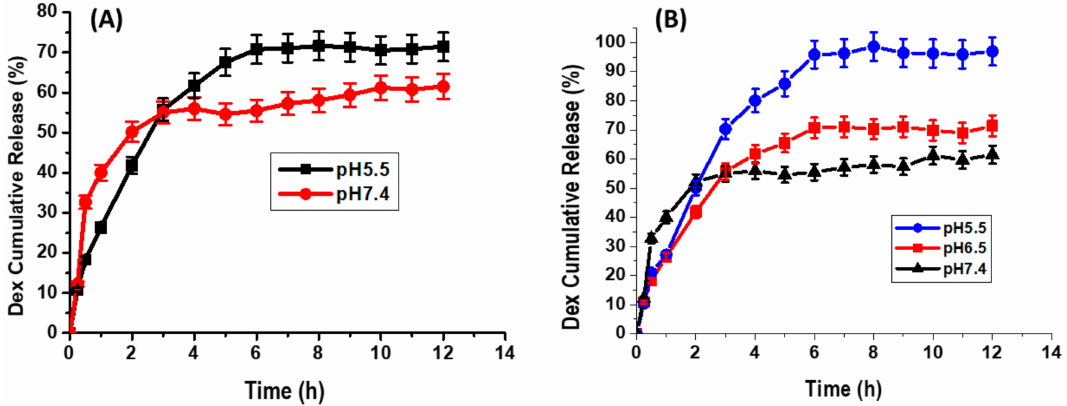
Figure 7. Dexamethasone release curves. Dex-MWCNTs in PBS buffer with pH 7.4 and pH 5.5 ( A ); Dex-PEG-MWCNTs in PBS buffer with pH 7.4, pH 6.5 and pH 5.5 ( B